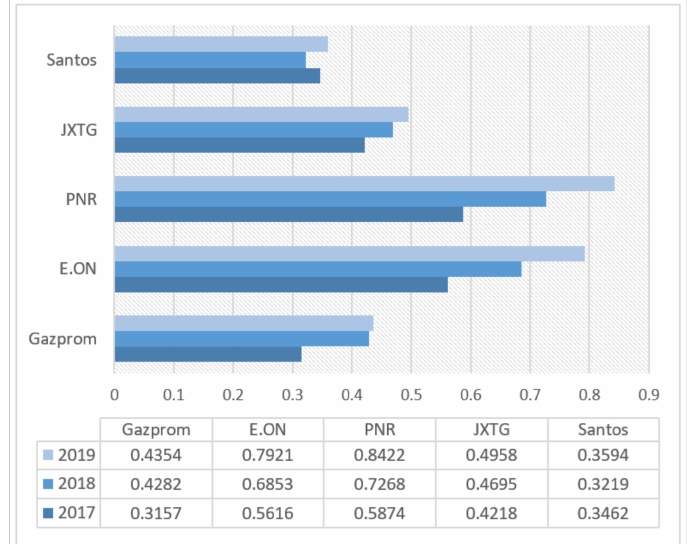
Figure 1. Evaluation of the activities of the companies under study in the context of the financial component ( FA fin ) . Source: compiled by the authors based on the materials of the surveyed